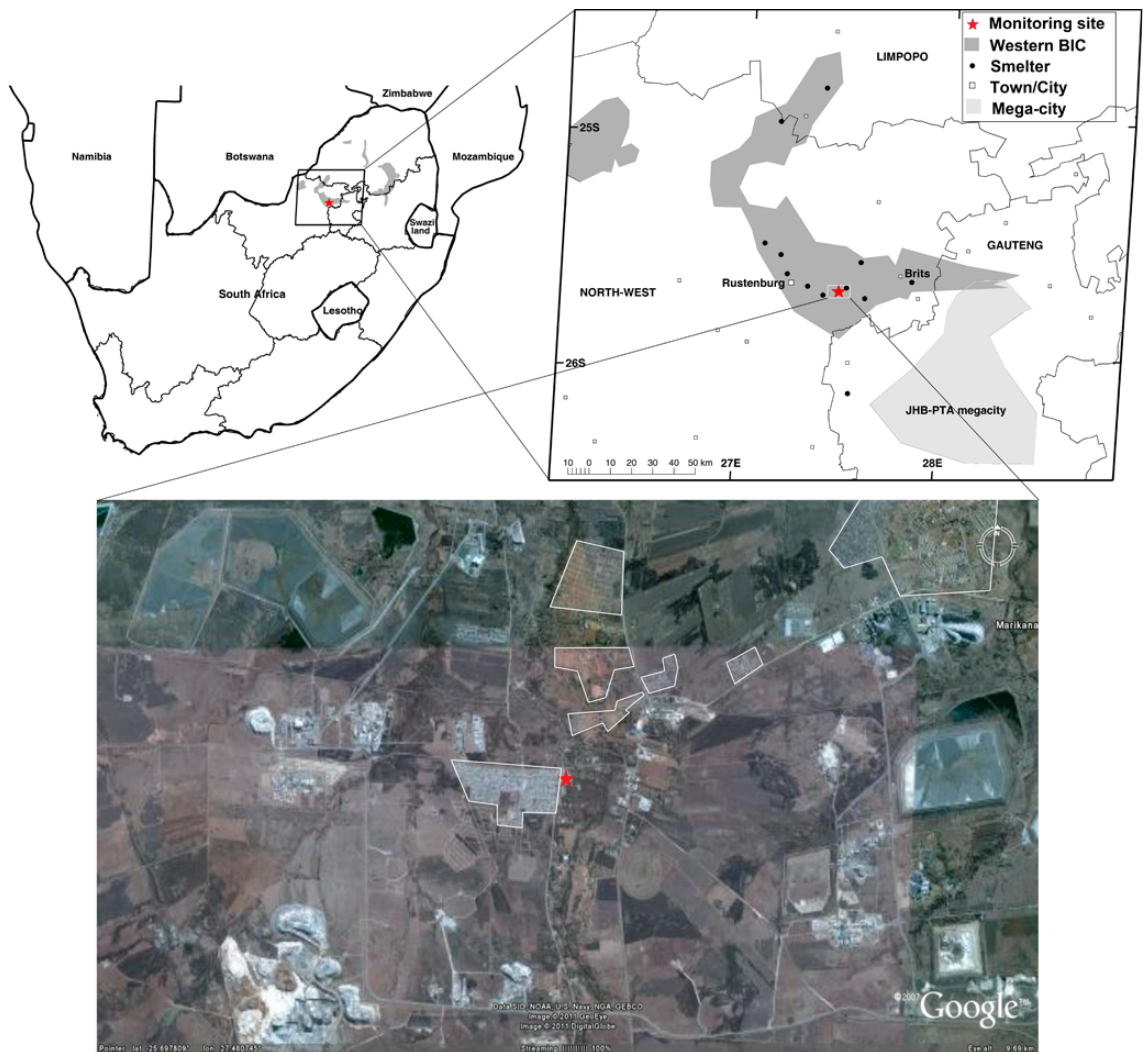
Fig. 1. A geographical map of southern Africa indicating the extent of the Bushveld Igneous Complex (BIC, in grey). The enlarged section of the geographical map indicates the western BIC, the proximity of the Johannesburg/Pretoria mega-city and the location of major point sources (pyrometallurgical smelters) in the western BIC. The Google map indicates the immediate surroundings of the measurement site (25 ◦ 41 0 54.51 00 S and 27 ◦ 28 0 50.05 00 E). The white outlined blocks indicate the occurrence of informal and semi-formal residential settlements in-between the mining and metallurgical